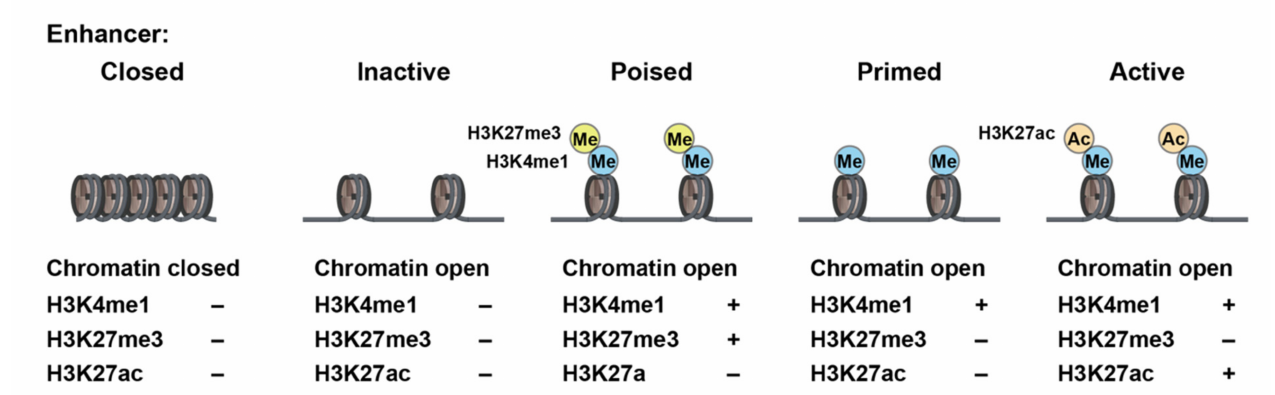
Figure 3. Histone marks and enhancer activity. The histone modifications,